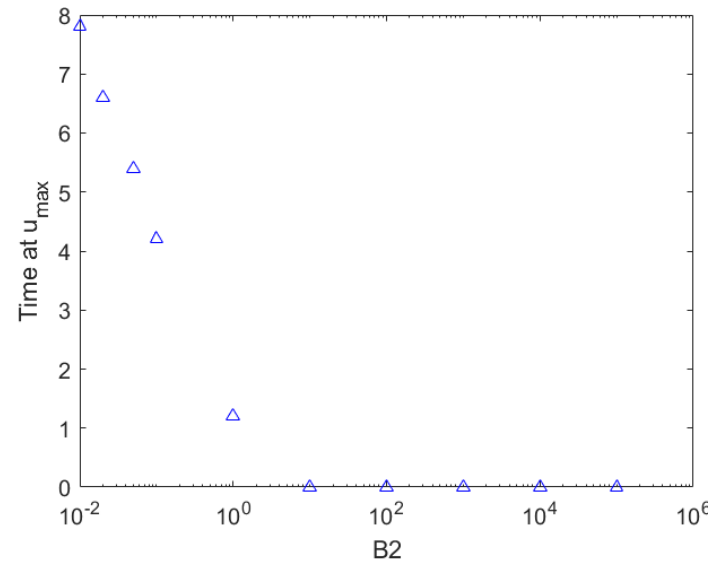
Figure 18. The control effort u 1 under the change of B 2 in Policy 2.